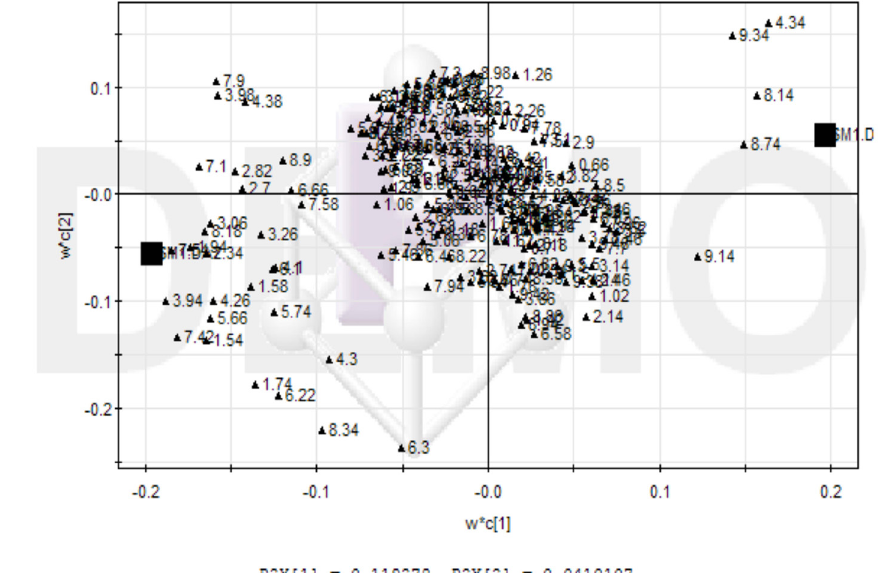
FIGURE 9 - Loading plot of the proton nuclear magnetic resonance ( 1 H NMR) spectra of serum samples from the control and medication groups (6-h, 12-h, and 24-h).